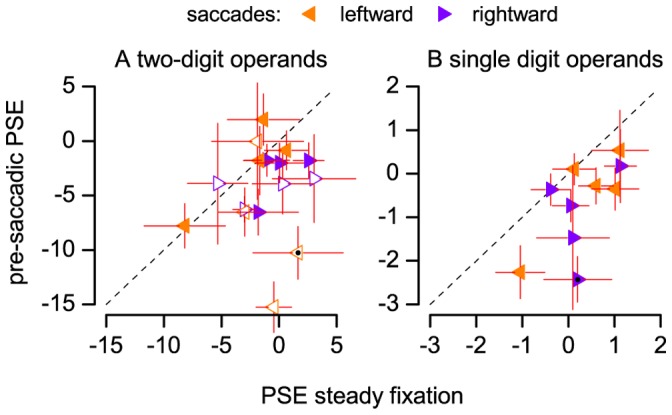
Peri-saccadic systematic errors in a mental arithmetic task.Subjective estimates (PSEs) of additions (filled symbols) and subtractions (hollow symbols) with two-digit (A) or single digit operands (B) presented during fixation (abscissa) or just before a saccade (ordinate). Error bars are standard errors computed by bootstrap. Black dots mark the PSEs of curves in Figure 1C–D.